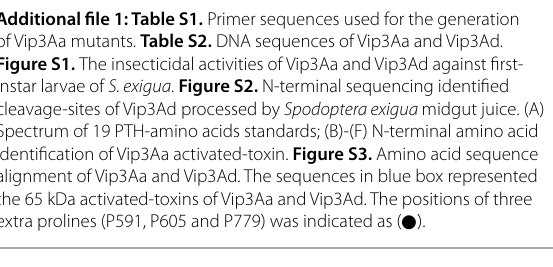
Figure S1. The insecticidal activities of Vip3Aa and Vip3Ad against first‑ instar larvae of S. exigua . Figure S2. N‑terminal sequencing identified cleavage‑sites of Vip3Ad processed by Spodoptera exigua midgut juice. (A) Spectrum of 19 PTH‑amino acids standards; (B)‑(F) N‑terminal amino acid identification of Vip3Aa activated‑toxin. Figure S3. Amino acid sequence alignment of Vip3Aa and Vip3Ad. The sequences in blue box represented